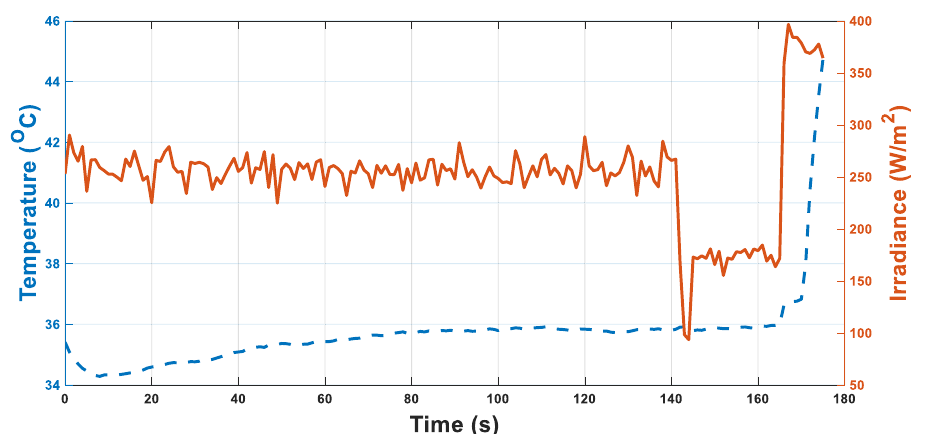
Figure 12. Temperature and irradiance variation in 1-day